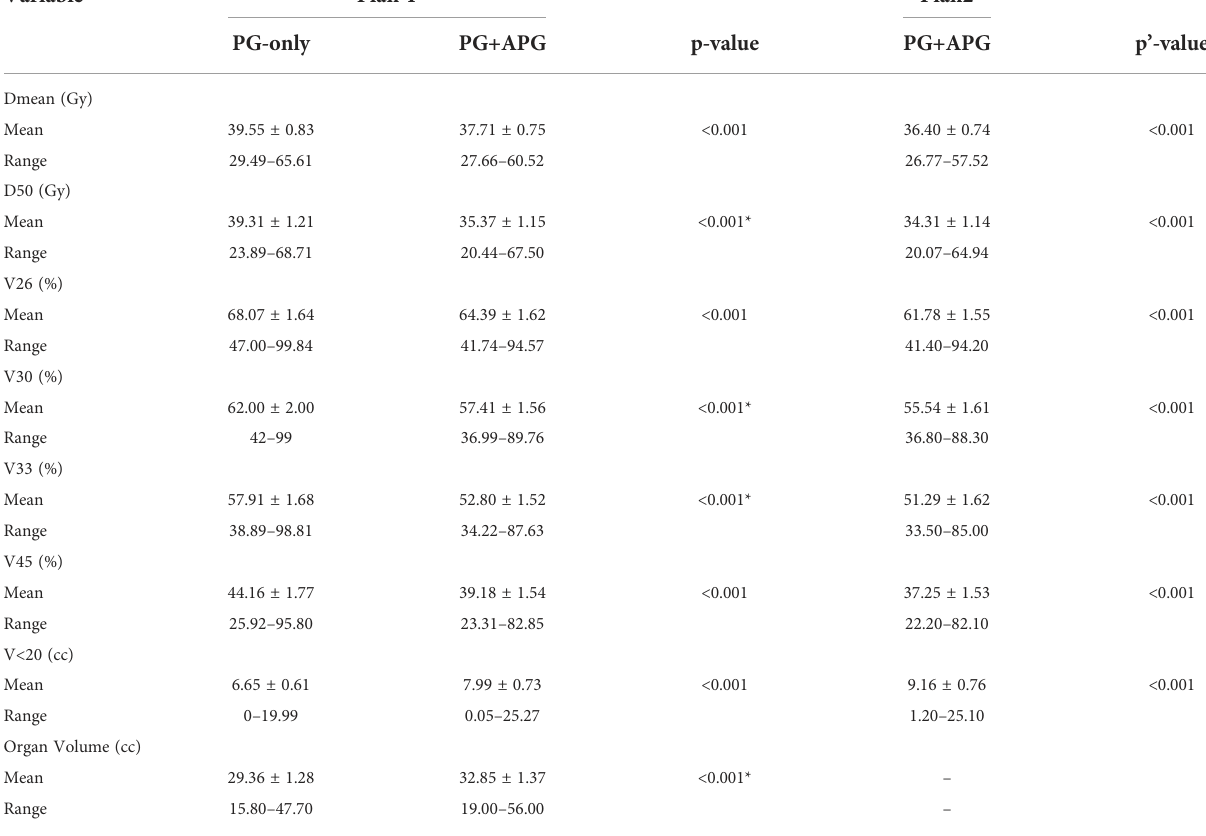
TABLE 2 Comparison of dosimetric parameters of PG-only and PG+APG in Plan1 and Plan2.